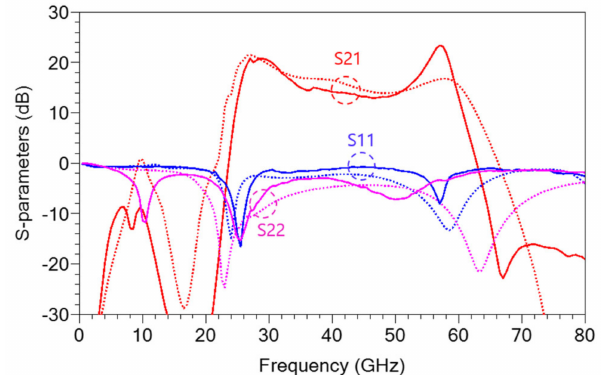
Figure 9. S-parameter of the proposed PA at V d1 = 3 V; V d2 = V d4 = 4 V; V d3 = 2.5 V; and V g1~4 = − 0.4 V (solid line: measurement, dashed line: